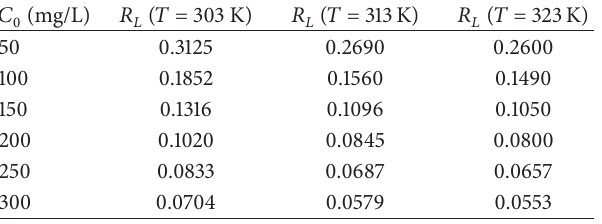
Table 2: 𝑅 𝐿 values at different temperature and initial MB concen- trations.